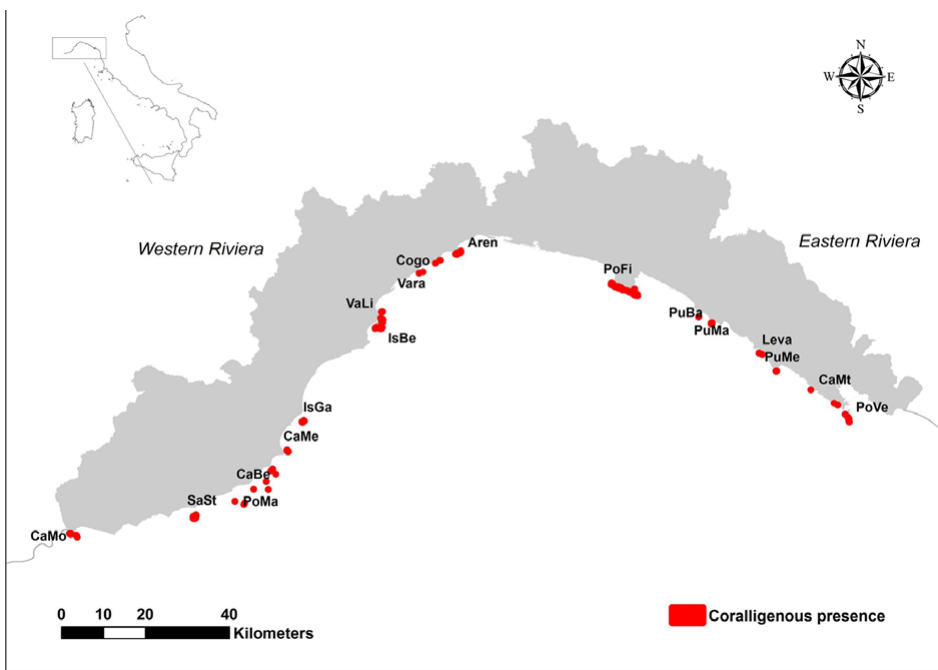
Fig. 1. – Presence of coralligenous assemblages in Liguria. To make small-scale presence visible, boundaries of polygon features have been artificially enhanced. Surface areas covered by these habitats appear much larger than they are in reality. CaMo, Capo Mortola; SaSt, Santo Stefano; PoMa, Porto Maurizio; CaBe, Capo Berta; CaMe, Capo Mele; IsGa, Isola Gallinara; IsBe, Isola Bergeggi; VaLi, Vado Ligure; Vara, Varazze; Cogo, Cogoleto; Aren, Arenzano; PoFi, Portofino; PuMa, Punta Manara; PuBa, Punta Baffe; Leva, Levanto; PuMe, Punta Mesco; CaMt, Capo Montenegro; PoVe, Portovenere.